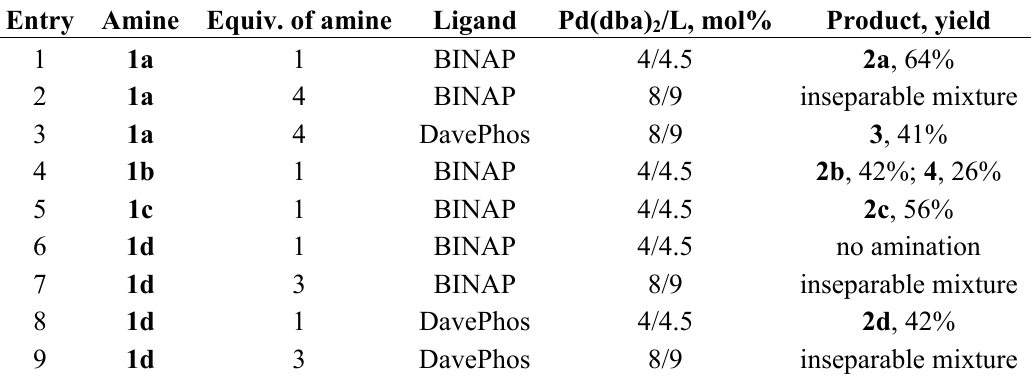
Table 1. Pd-catalyzed amination of